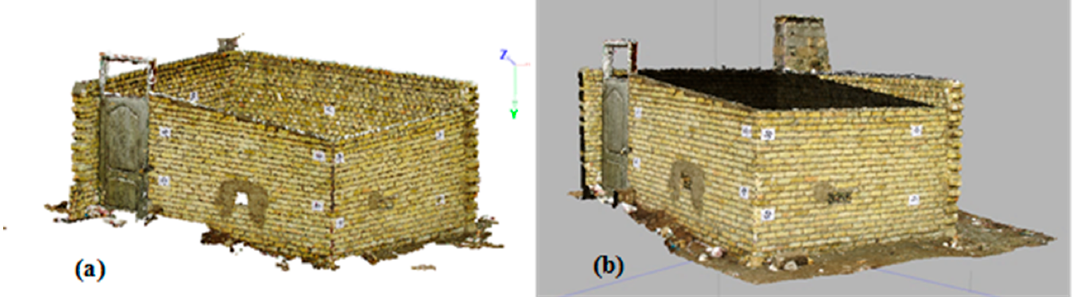
Figure 11. The generated point cloud: ( a ) SFM/CMVS/PMVS algorithm ( b ) proposed photogrammetric Multi-View Stereo method (Case study 1).